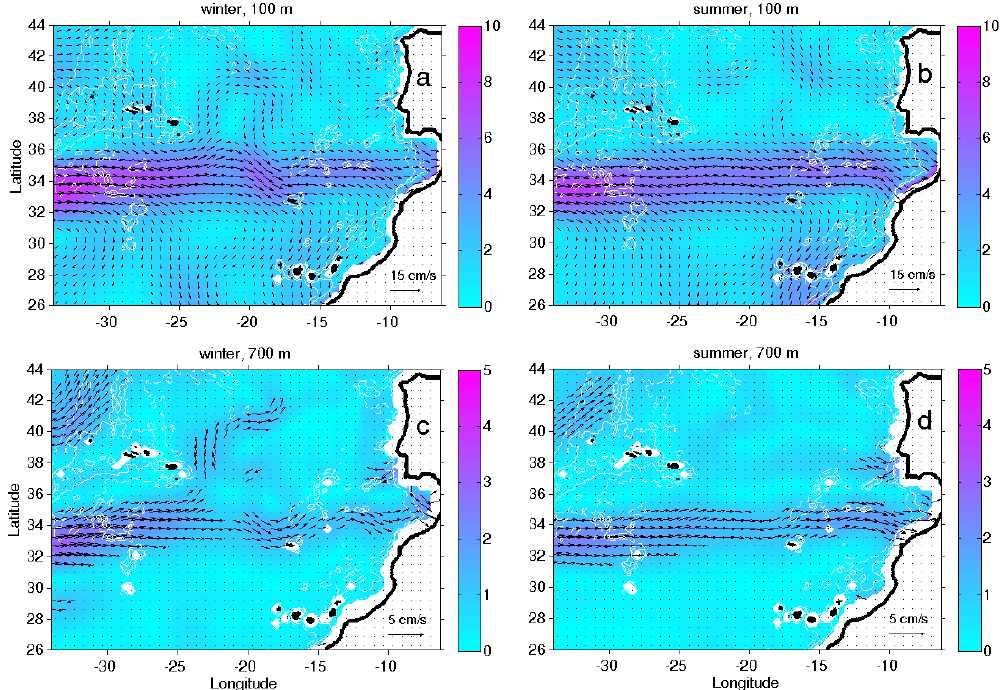
Figure 13. Velocity of geostrophic currents (cms − 1 ) at the 100m and 700m levels, referenced to 1900m: (a) 100m winter, (b) 100m summer, (c) 700 m winter, (d) 700m summer. Velocity vectors are